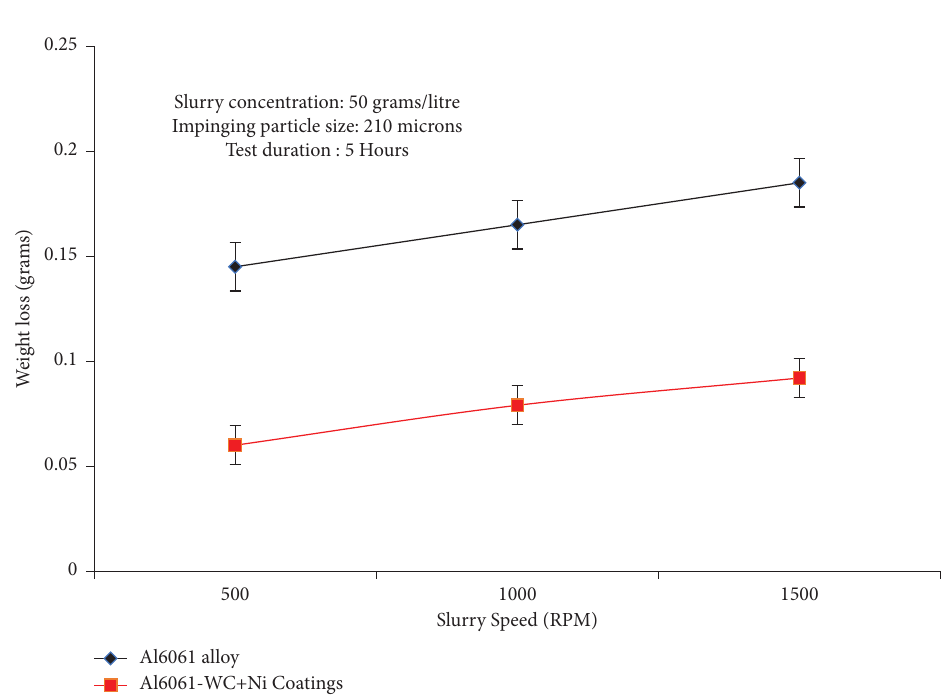
Figure 7: Infuence of slurry concentration on slurry wear performance.